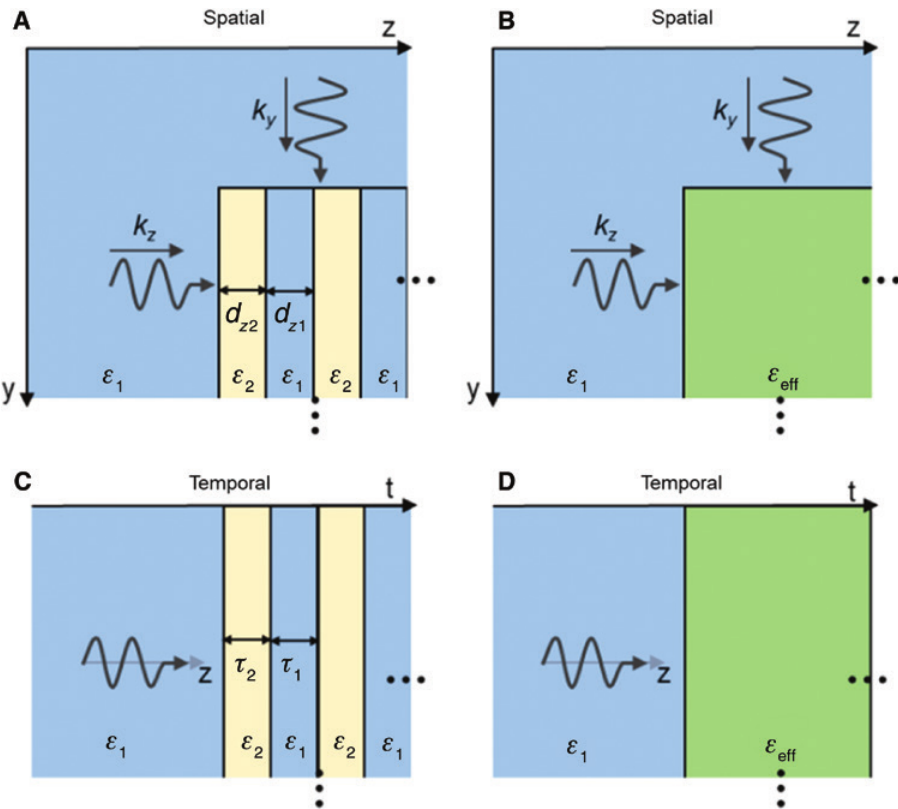
Figure 1: Schematic representation of the spatial and temporal multilayered metamaterials and their corresponding effective media. Top row: Schematic representation of a well known spatial multilayered structure made with alternating subwavelength layers of two media with different permittivity ε and ε (A), along with the effective medium produced by such spatial multilayered medium (B). Bottom 1 2 row: Schematic representation of the temporal analogue, i.e. the proposed multistepped temporal metamaterial made by alternating in time subperiod steps of two different permittivities ε and ε (C), along with the temporally effective medium produced by such temporal 1 2 multistepped medium